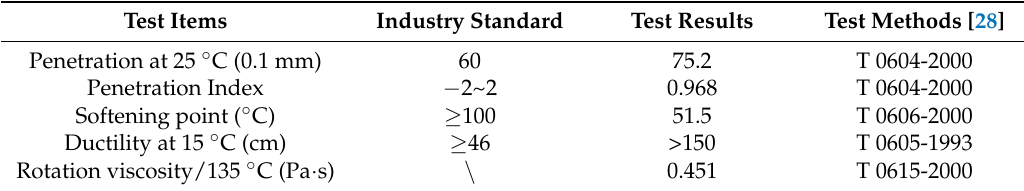
Table 1. Technical properties of base asphalt binder AH-70.